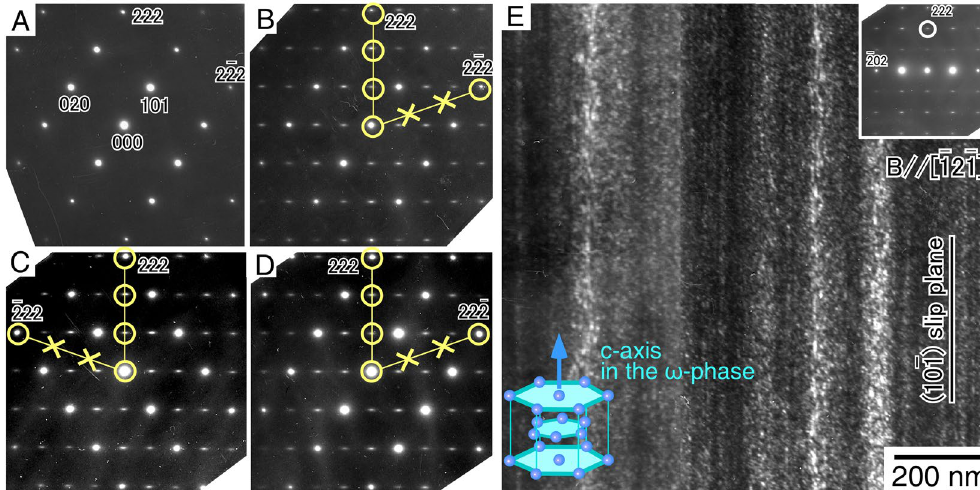
Figure 2. Curious ω -phase formation induced by the cyclic deformation. ( A ) SAED pattern in undeformed specimen observed along the [10 1 ] direction. ( B–D ), SAED patterns of the specimen cyclically deformed at Δε /2 = 1.1% to ~920 cycles, observed along the [10 1 ], [01 1 ], and [ 1 10] directions, respectively. The extra spots derived from the ω -phase appear along only one of the four < 111 > directions. ( E ) Dark-field image showing the abundant precipitation of the ω -phase, observed along the [ 1 2 1 ] direction. The extra spot used for the observation is denoted by the circle in the SAED